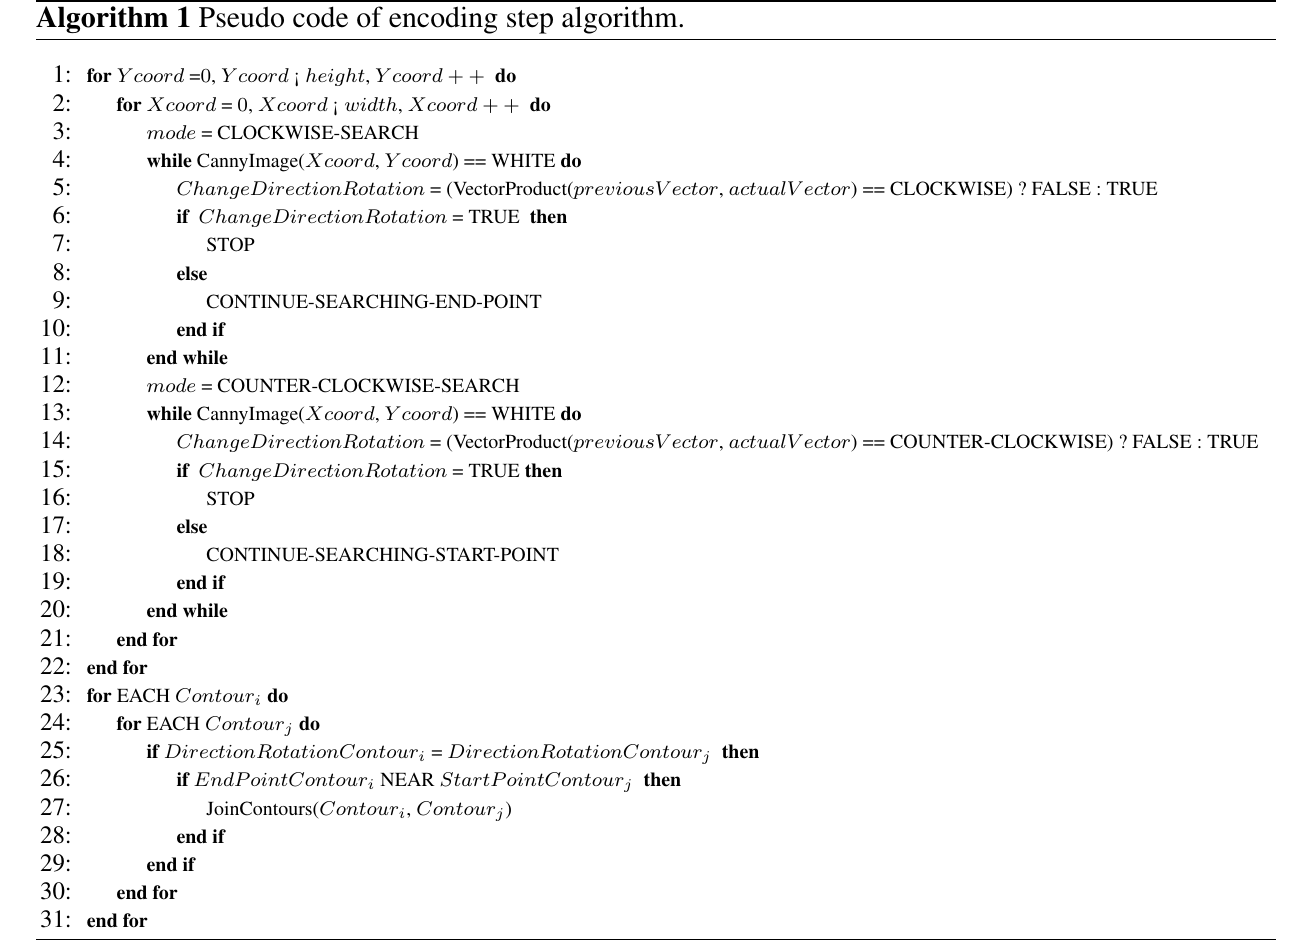
Algorithm 1 Pseudo code of encoding step